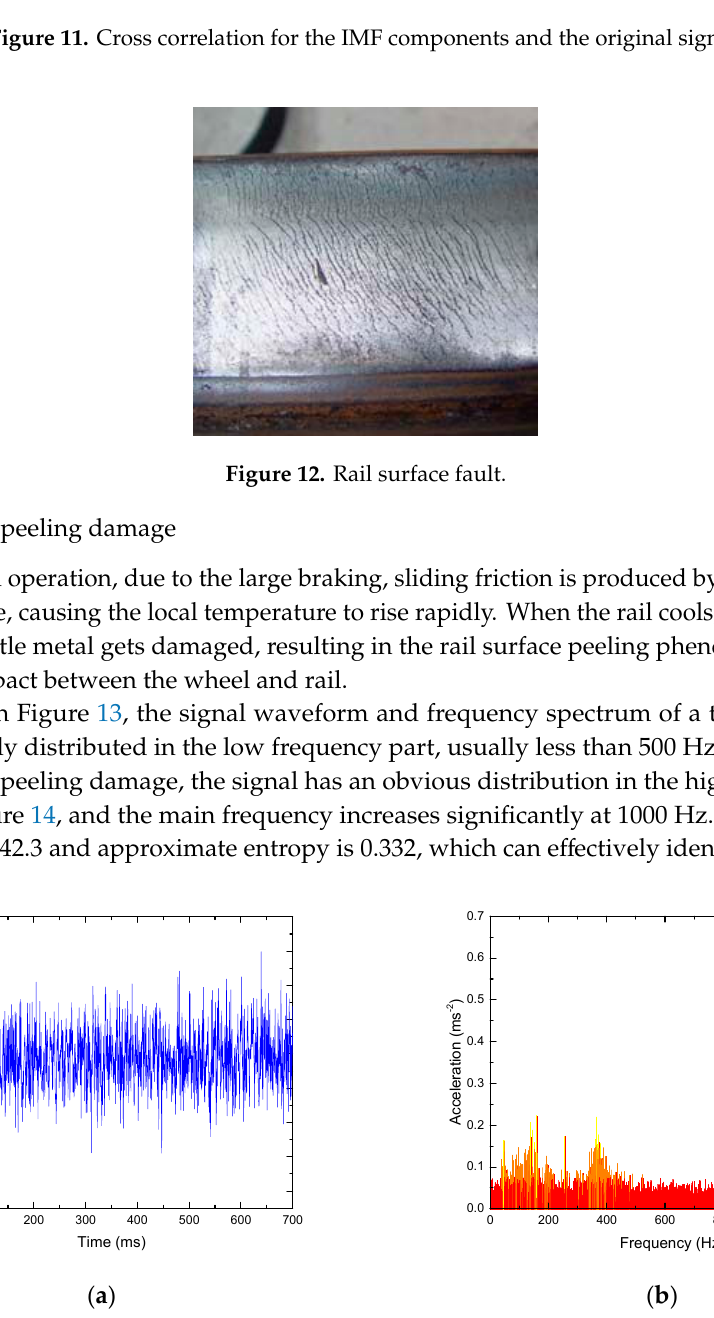
( b ) Figure 14. Spectrum analysis of a rail vibration signal with peeling damage. ( a ) Waveform; ( b ) frequency spectrum.